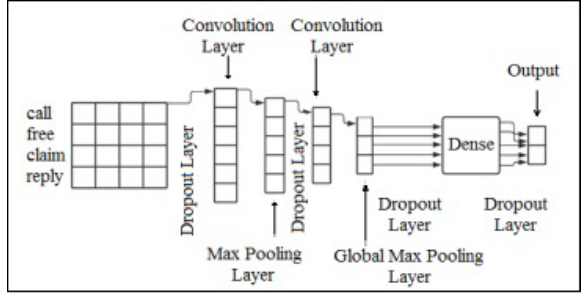
Fig. 4. Proposed CNN Architecture.